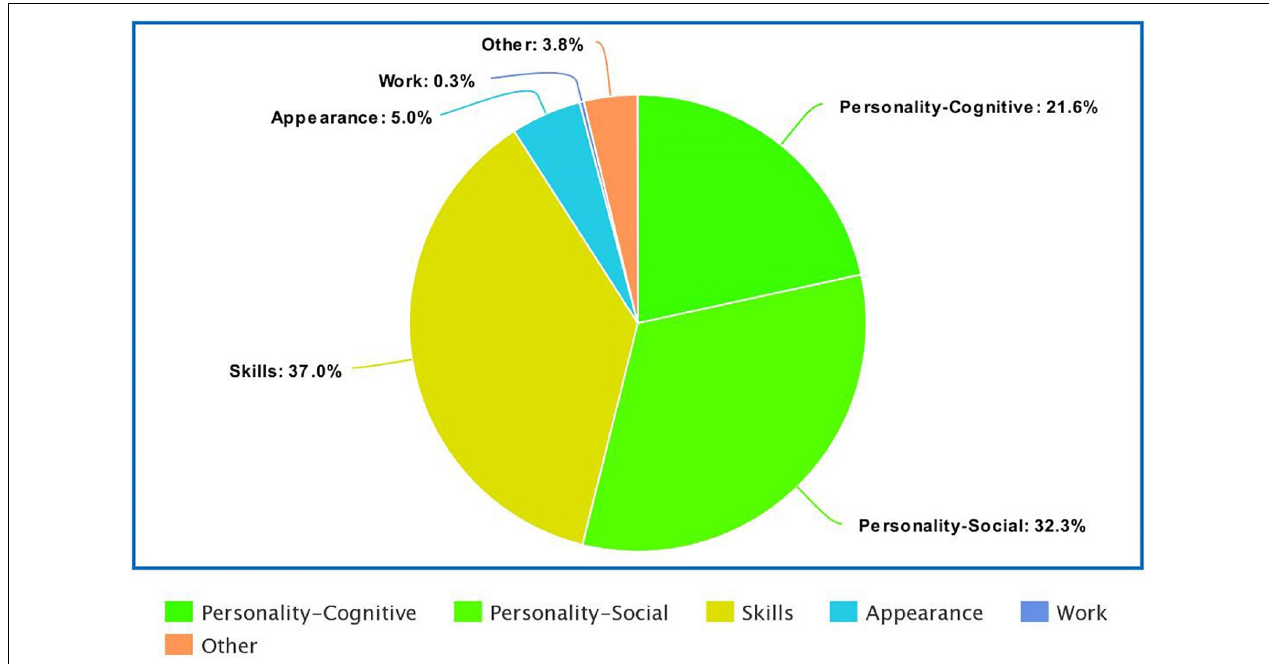
FIGURE 4 | Types of words used that do NOT describe scientists (organized by